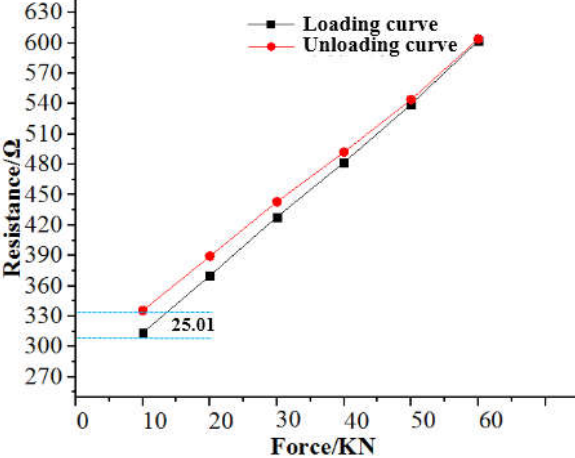
Figure 10. Polymer-based flexible sensor hysteresis characteristic curve.